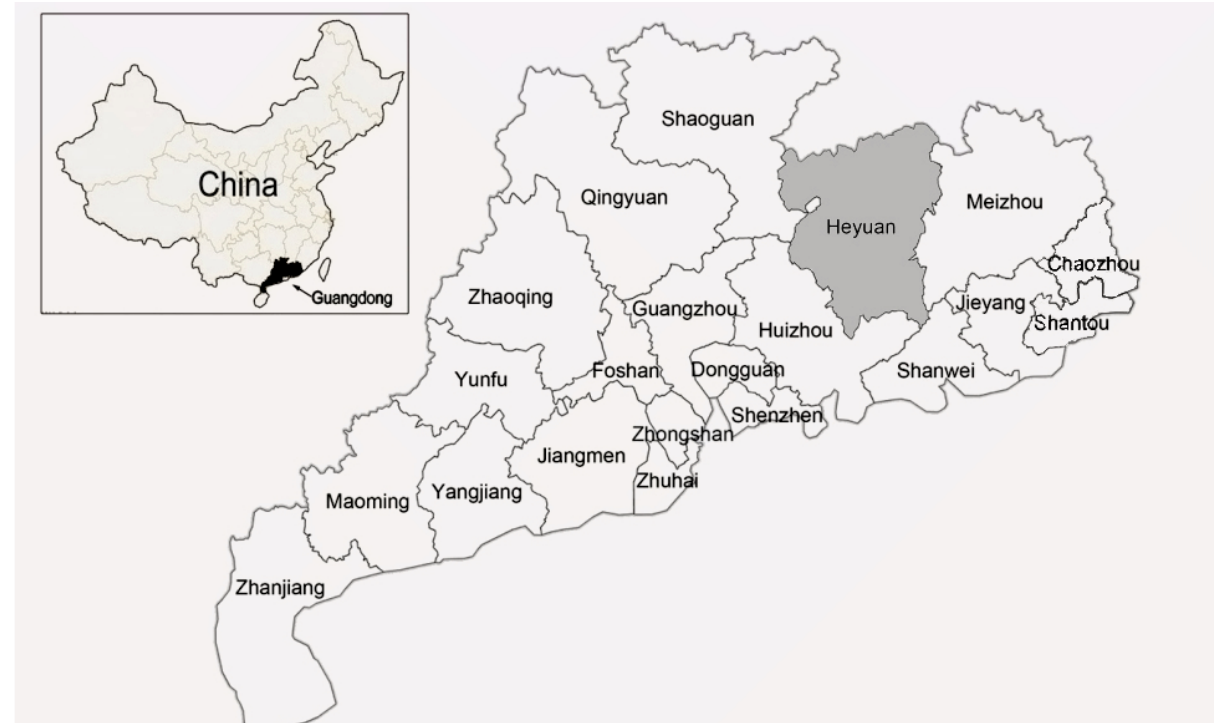
Figure 1 – Geographic location of Heyuan city in Guangdong